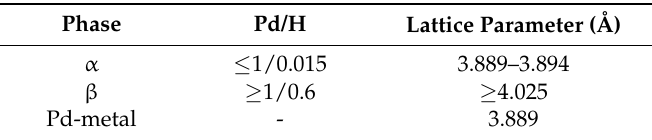
Table 9. Characteristics of Pd/H phases and pure Pd